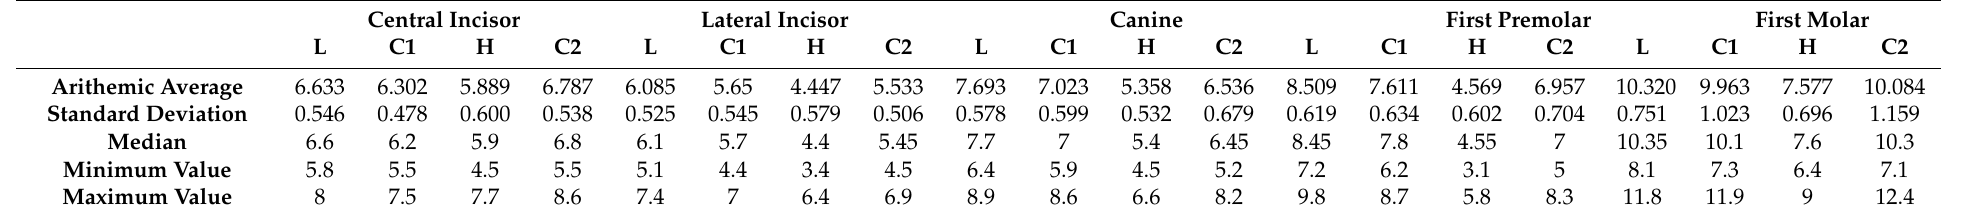
Table 1. Results of the measurements (mm) of L, C1, H, and C2 for the central incisor, lateral incisor, canine, first premolar, and first molar (mm). Central Incisor Lateral Incisor Canine First